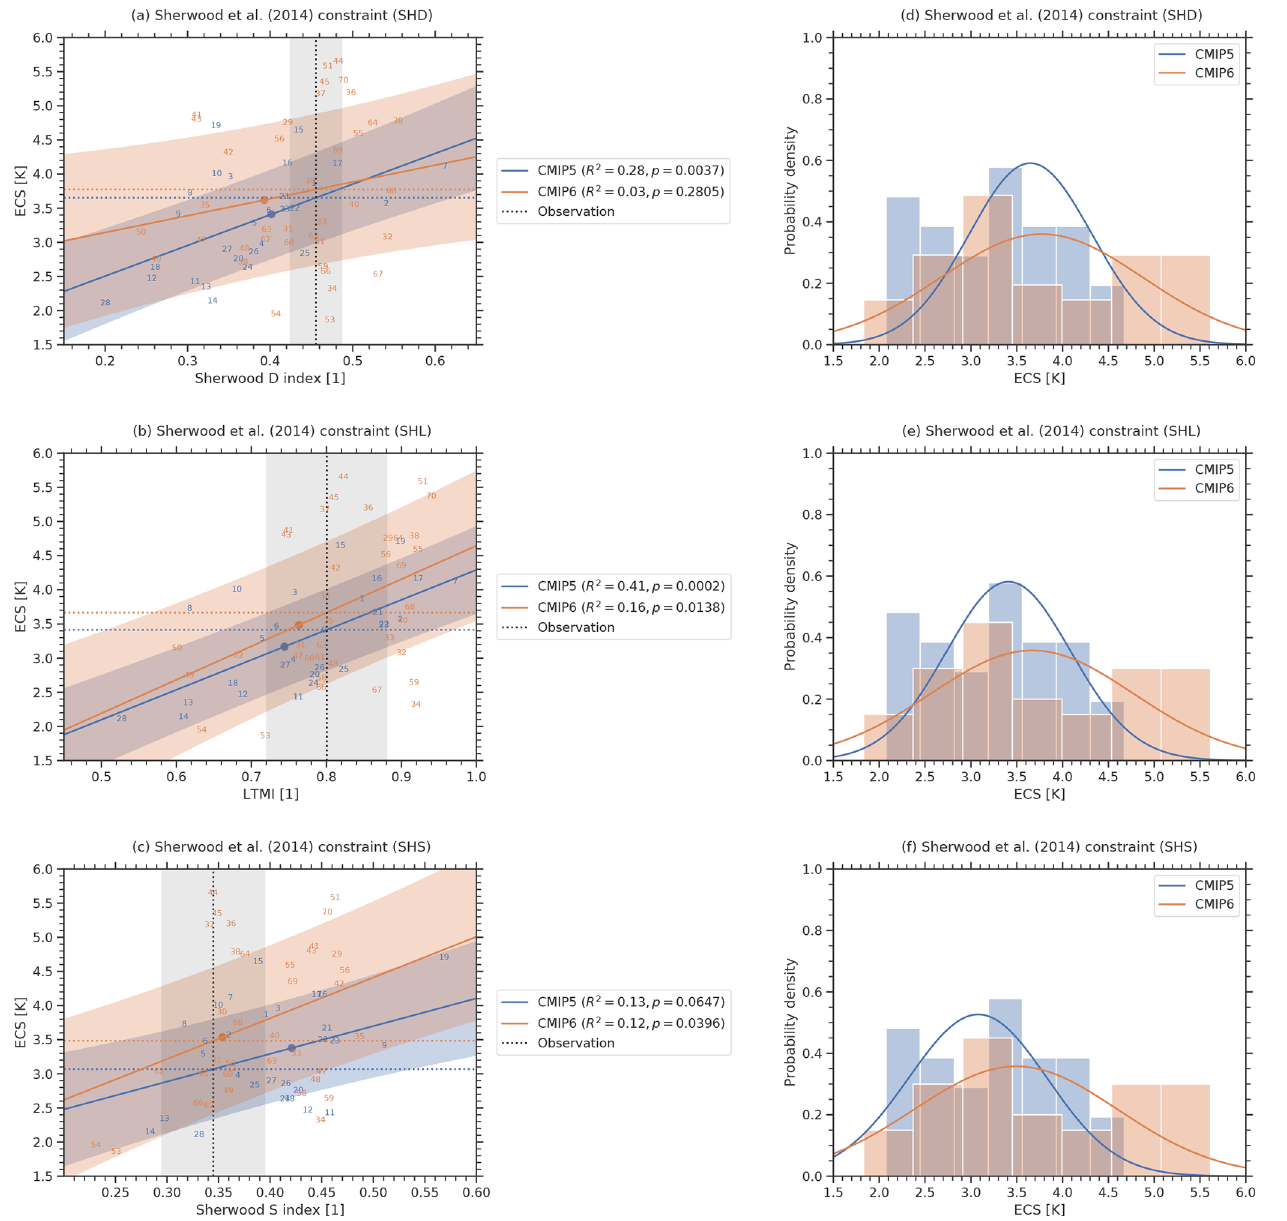
Figure 3. As in Fig. 2 but for the constraints SHD, SHL, and SHS.